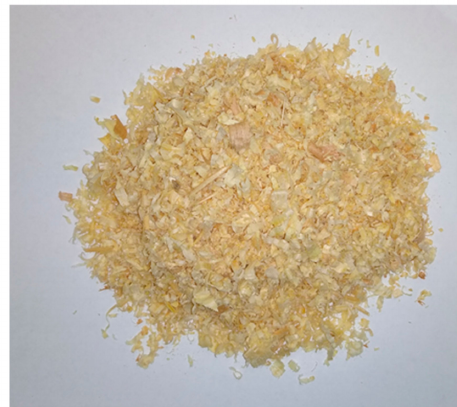
Figure 1. Sawdust used in the research.